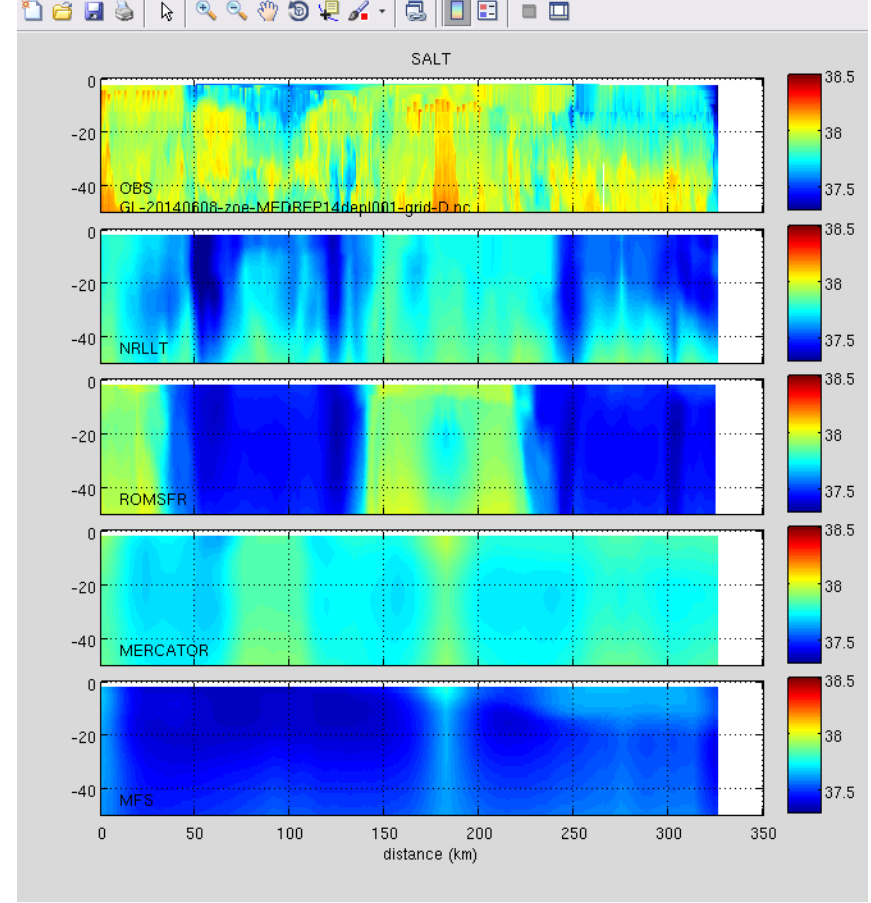
Figure 4. Vertical sections of salinity data from an ocean glider compared with virtual glider paths through four numerical models. Use of CF conventions and NCTOOLBOX allowed the vertical coordinates from these four different models to be computed without any model-specific code. © North Atlantic Treaty Organization, all rights reserved. Provided by